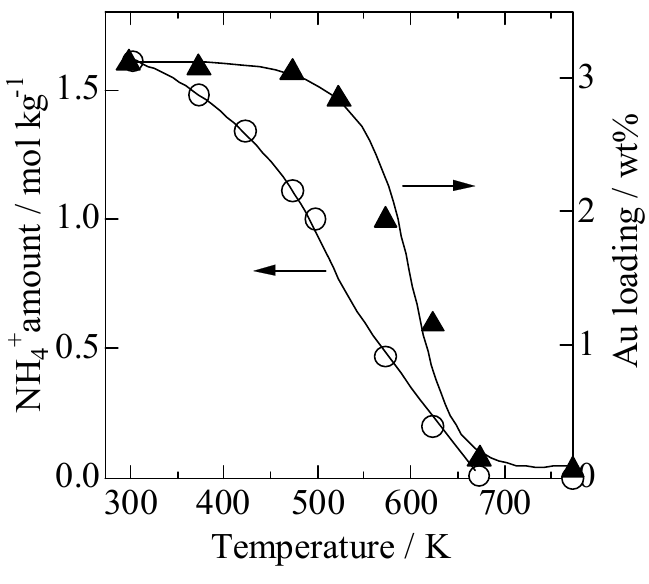
Figure 1. Dependence of NH 4+ concentration in ultrastable Y (USY) zeolites and Au loading on thermal treatment temperature of NH 4+ -USY